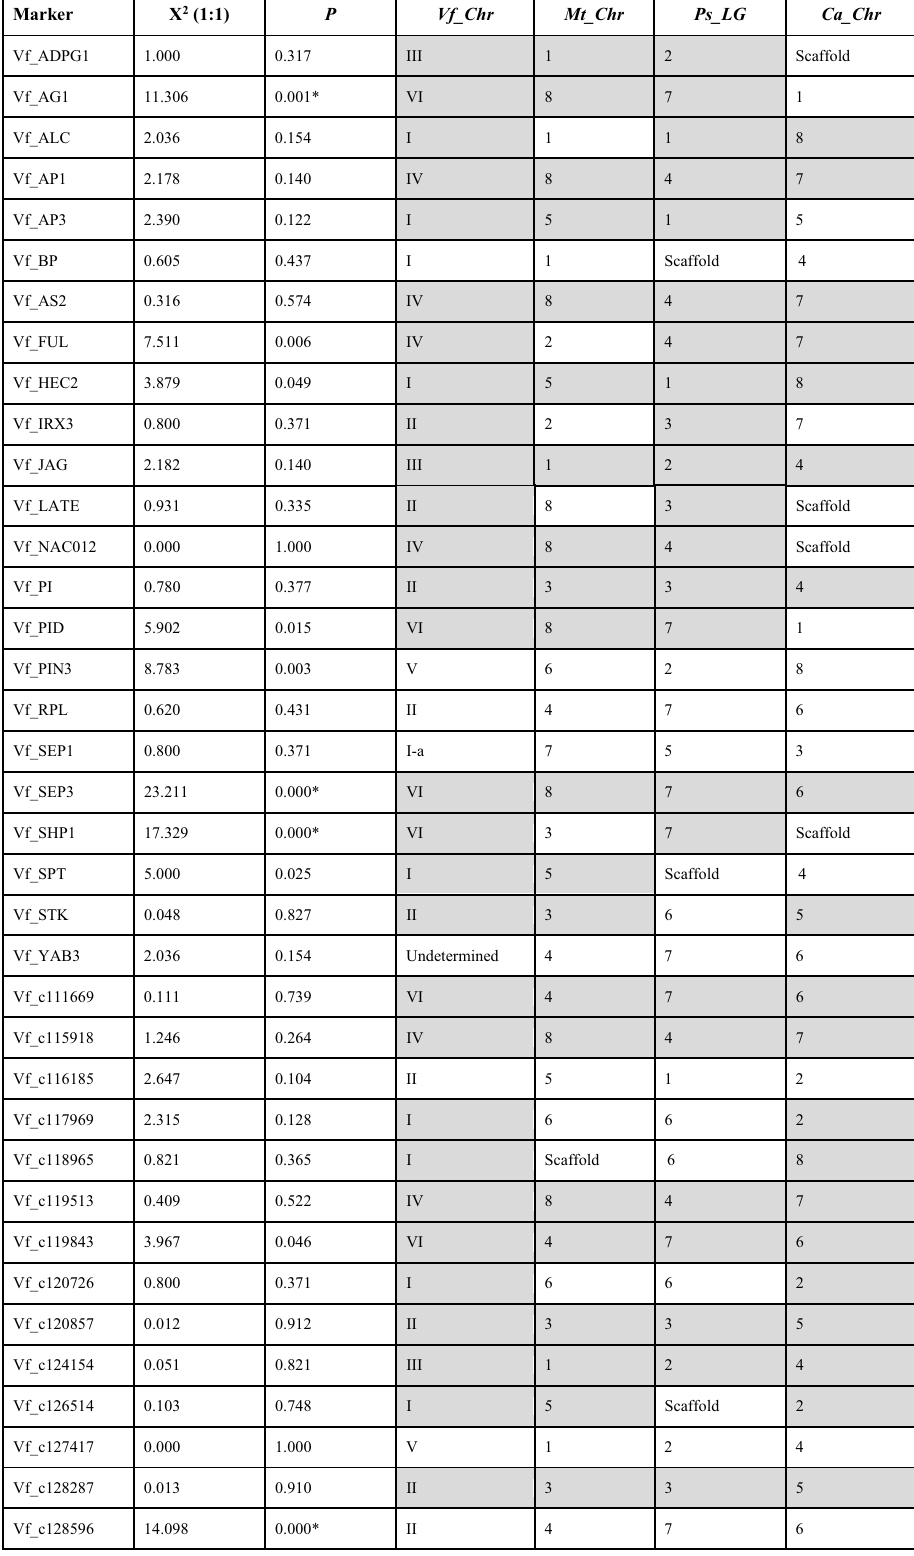
Table 3. Genetic segregation, chi-square test and location of the dehiscence related gene markers in faba bean (Vf) and related legume species: Mt, Medicago truncatula ; Ps, Pisum sativum ; Ca, Cicer arietinum . Grey cells indicate syntenic chromosomes (Chr) and linkage groups (LG). Absence of fit to the expected 1:1 segregation is indicated by an